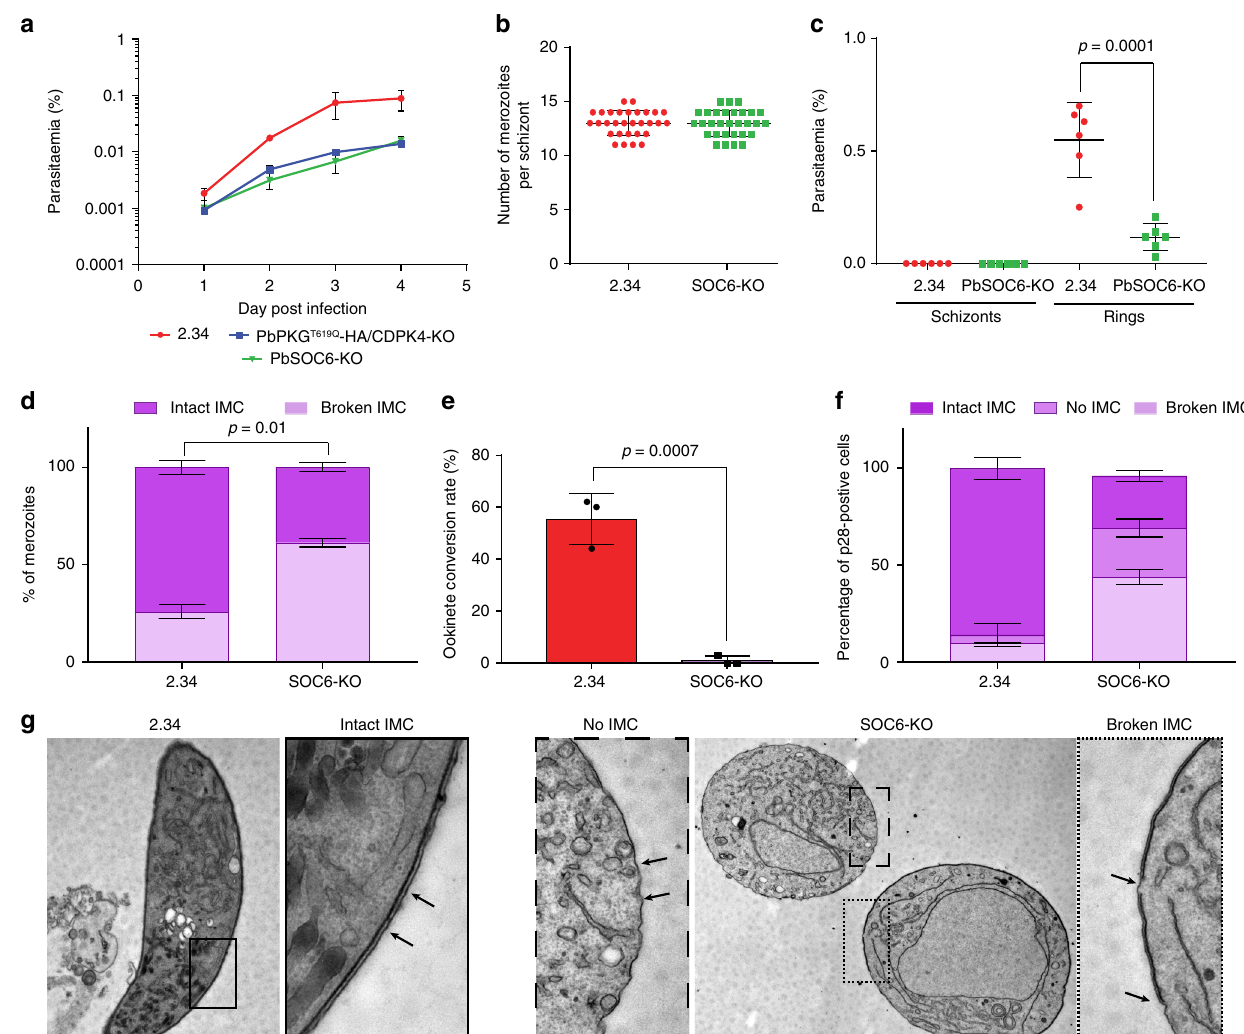
Fig. 4 The CDPK4 substrate SOC6 is important for the IMC stability in merozoite and ookinete. a Effect of soc6 deletion on the growth of asexual blood stage parasites (error bars show standard deviations from 2 independent infections). b Number of merozoites per schizont in control and SOC6-KO parasites (data shown is from 4 independent in vitro cultures). c Parasitaemia observed 1 h after the intravenous injection of control or SOC6-KO mature segmented schizonts (data shown is from four independent schizont cultures, two-tailed t -test). d Electron microscopy analysis of mature SOC6-KO and WT schizonts (error bars show standard deviations from duplicates, n WT = 140, n SOC6-KO = 267). e Ookinete conversion rate of 2.34 and SOC6-KO lines (error bars are standard deviations from three independent ookinete cultures, two-tailed t -test). f Ultrastructural analysis of WT and SOC6-KO highlighting the integrity of the IMC in WT and SOC6-KO p28-expressing cells (error bars are standard deviations from the mean, two ookinete cultures, n WT = 34, n SOC6-KO = 27). g Representative images of IMC defects observed in SOC6-KO parasites. Scale bar: 2.34, 1 µ m (lower magni fi cation) and 200 nm (higher magni fi cation); SOC6-KO, 1 µ m (lower magni fi cation) and 500 nm (higher magni fi